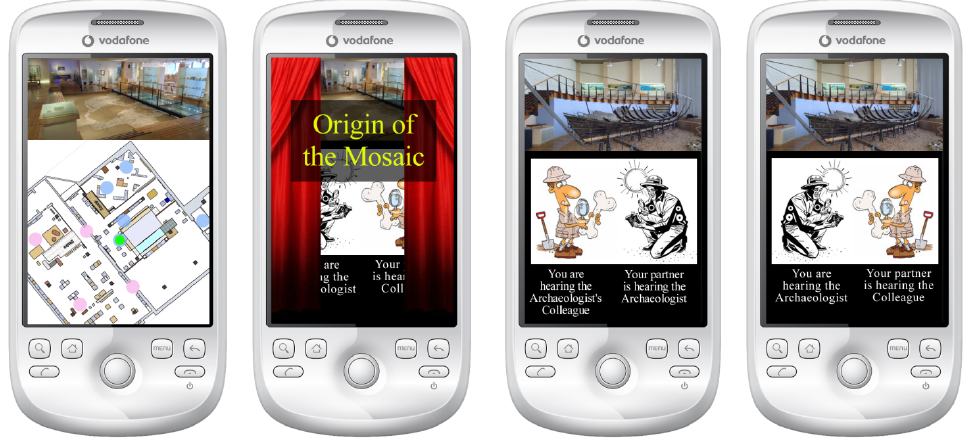
Figure 1. DramaTric graphic interface: museum map, start of a drama, and variations for different